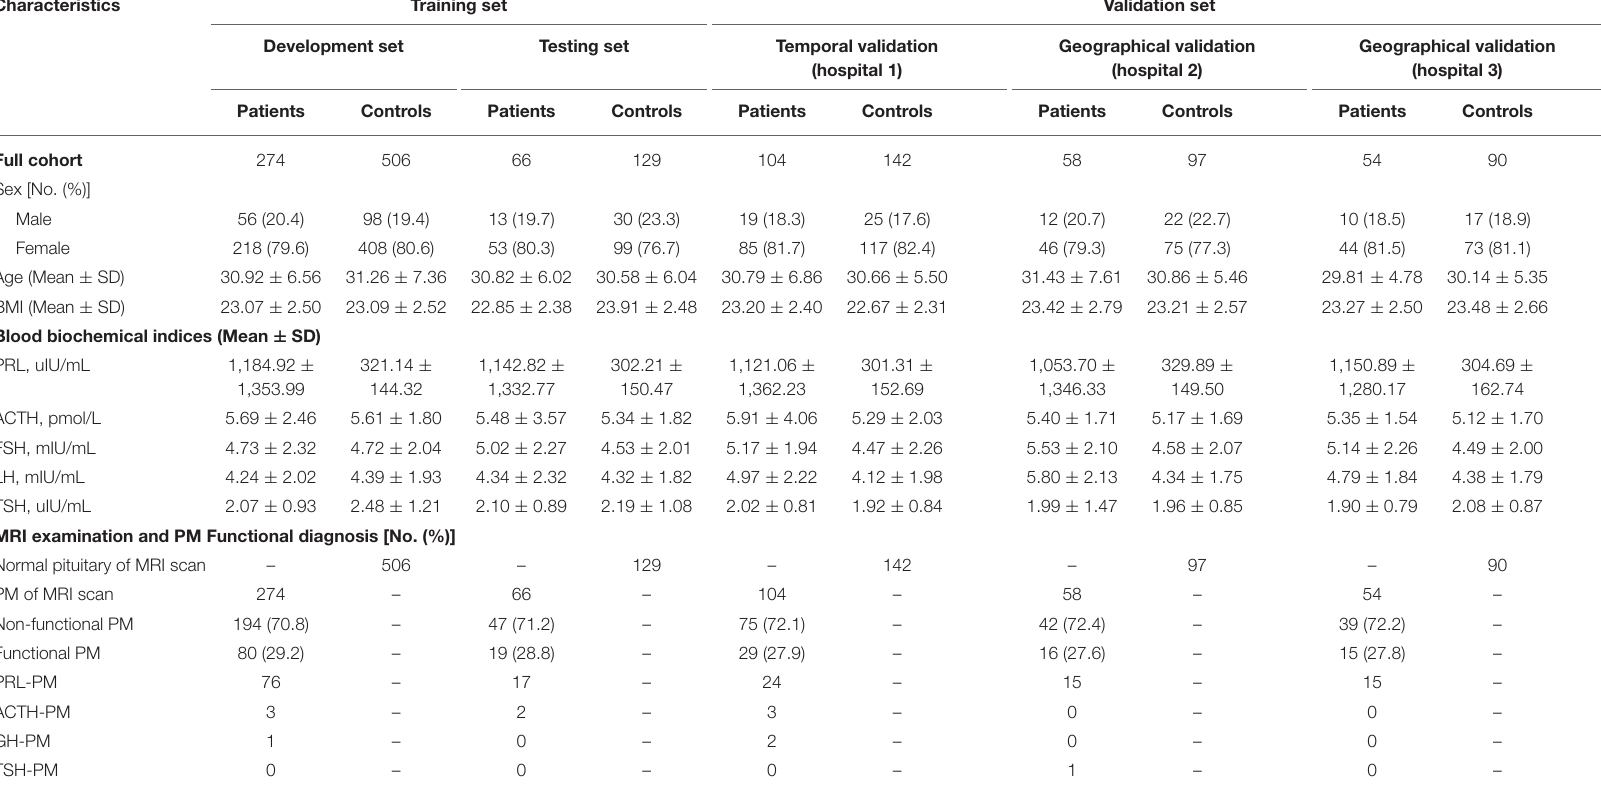
TABLE 1 | Description and characteristics of the training and validation